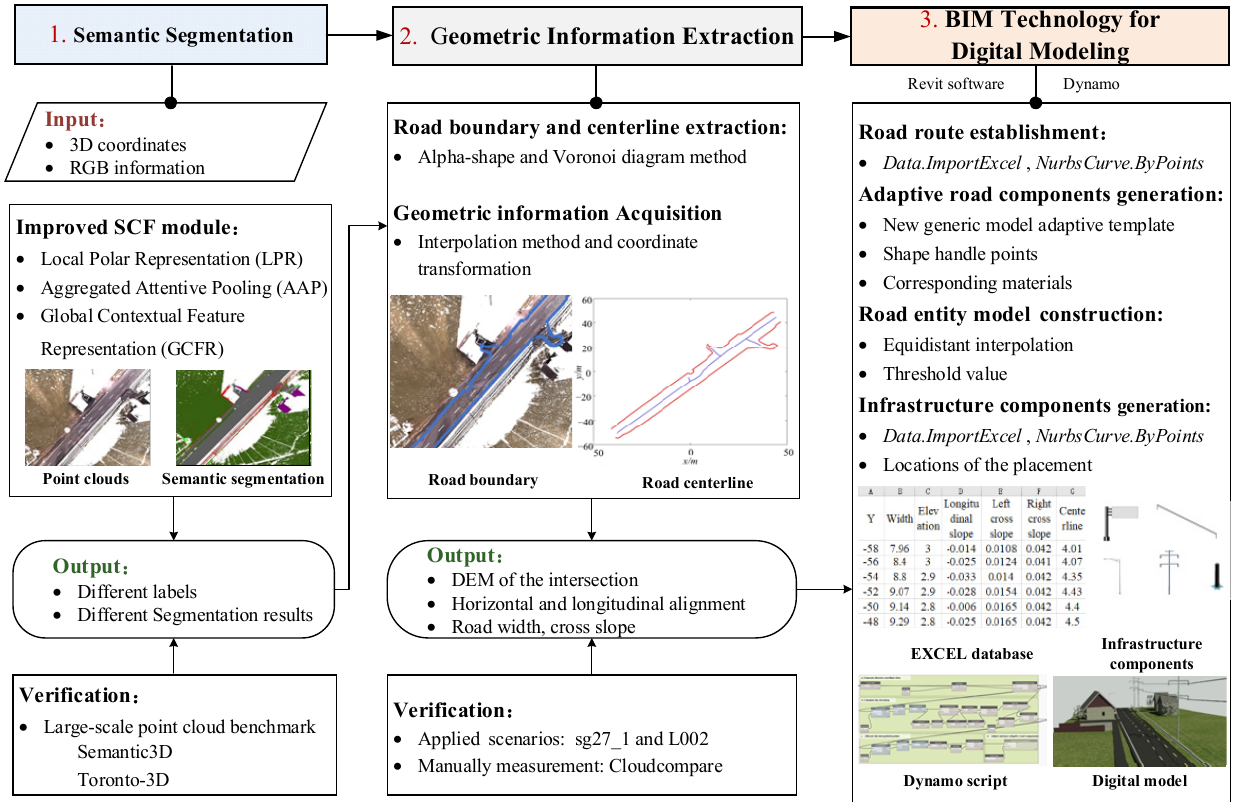
Figure 1. Workflow of the methods.